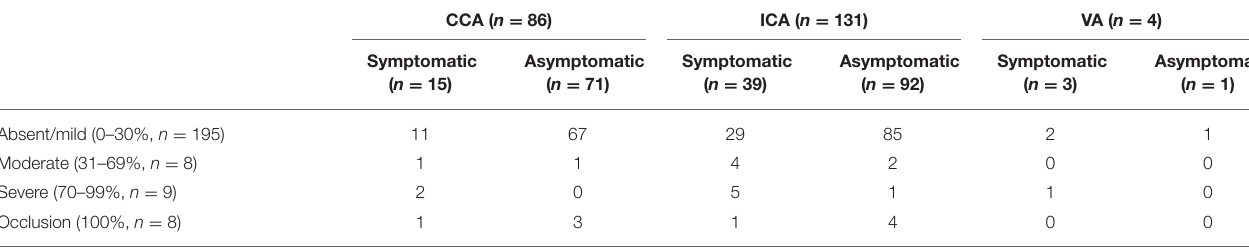
TABLE 2 | Degree of stenosis of carotid artery and vertebral artery.